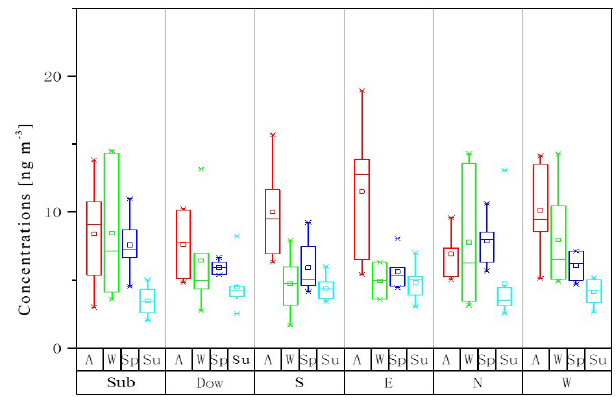
Figure 1. Levels and seasonal variation of (cid:54) 7 OPEs in PM 2 . 5 at six sampling sites. A: autumn, W: winter, Sp: spring, Su: summer, Sub: suburbs, Dow: downtown, S: south, E: east, N: north, W: west.